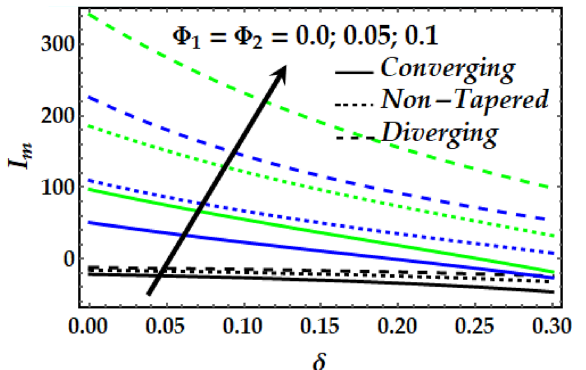
Figure 18. Impedance profile against distinct values of (cid:31) 1 , (cid:31) 2 .